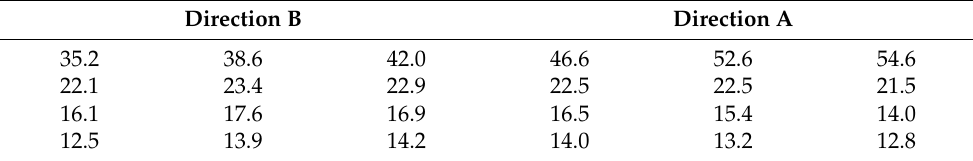
Figure 10. Visualisation of representative Section 24 and the planes. The results were obtained for both measurement planes (Tables 2 and 3). Table 2. Measurements on the road surface 0.0 m.